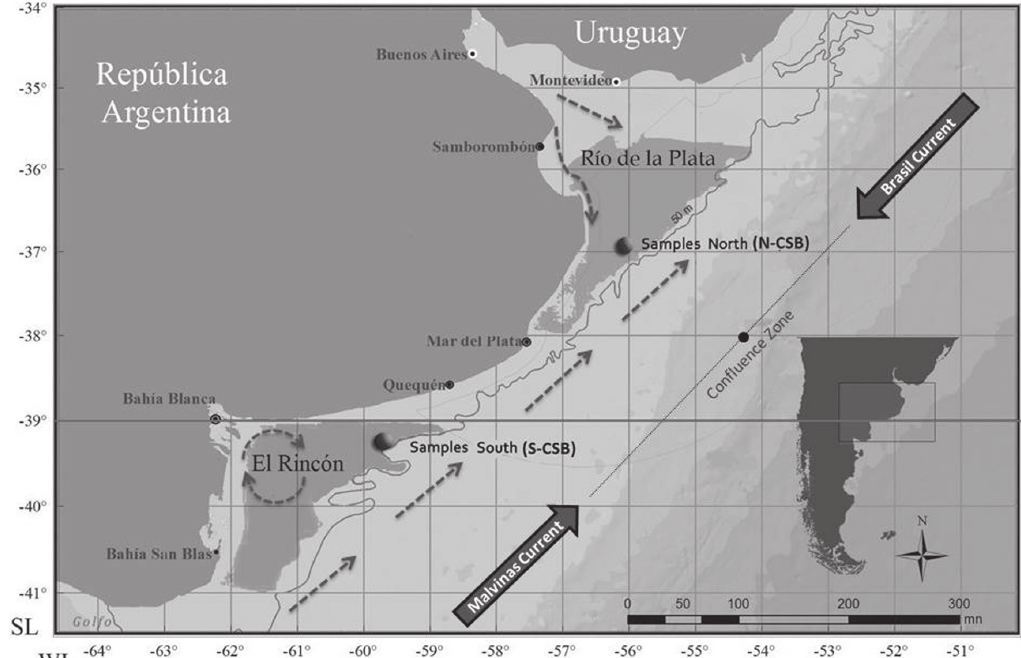
Fig. 1. Map showing the study area and sampling sites. In the gray-shaded area, the distribution of Pagrus pagrus and the sampling sites both to the north (N-CSB) and to the south (S-CSB) of Buenos Aires coastal waters can be observed. The Patagonian coastal Current, which mainly move northward over the continental shelf, are represented with grey dashed arrows. Along the edge of the continental slope, the thick arrows represent the Malvinas Current that moves northward and meets the Brazil Current in the so-called Confluence